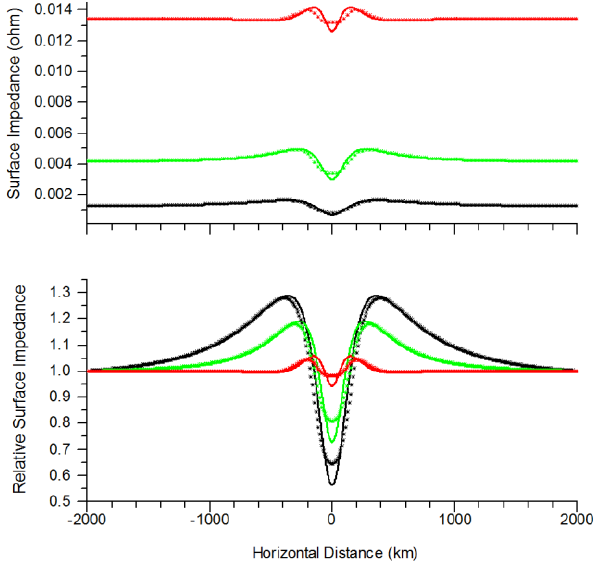
Fig. 6. The magnitude of the surface impedance for a layered earth conductivity model of Quebec is shown for three different periods for a 1km line current (solid) and a 200km wide current (symbols). The colours of the curves represent the periods (black 1800s, green 300s and red 30s). The lower graph shows the relative impedance where each value is normalized by the value at x = − 2000km. The computations are based on FEM.